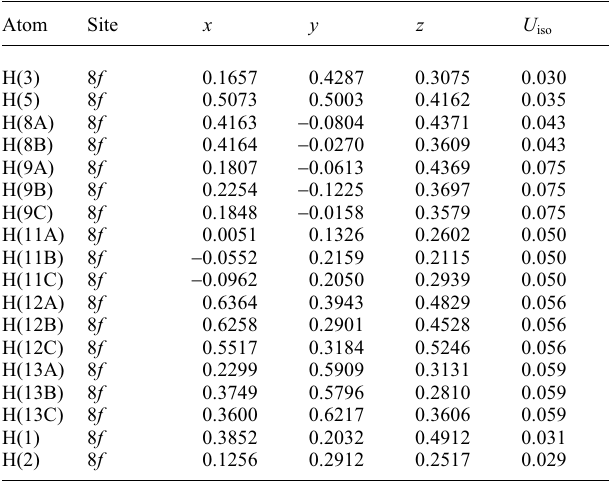
Table 2. Atomic coordinates and displacement parameters (in Å 2 )